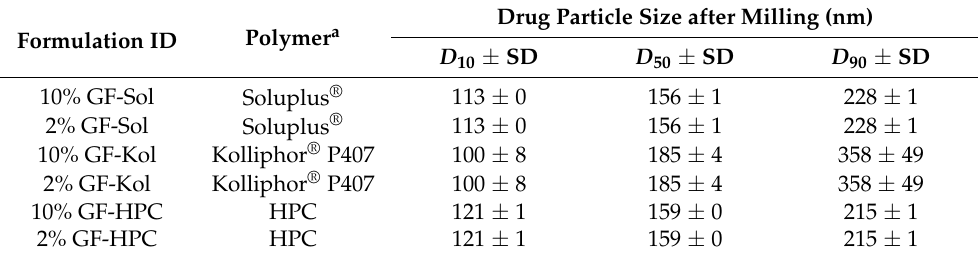
Table 1. Formulations and particle sizes of the drug (GF) nanosuspensions fed to the extruder during the nanoextrusion